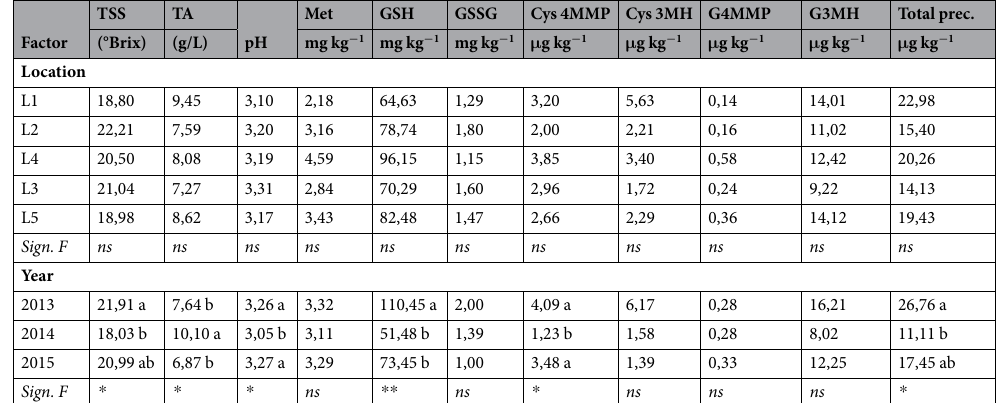
Table 4. Effect of location and season on basic maturation parameters, methionine (Met), glutathione (GSH), oxidized glutathione (GSSG) and thiol precursor content in Sauvignon Blanc grapes from Friuli Venezia Giulia (Italy) in 2013–2015. Data were analysed with mixed-model ANOVA (location, fixed factor; year, random factor - ns, not significant; * p < 0.05; ** p < 0.01). Different letters represent significant differences in Tukey’s HSD test (p <